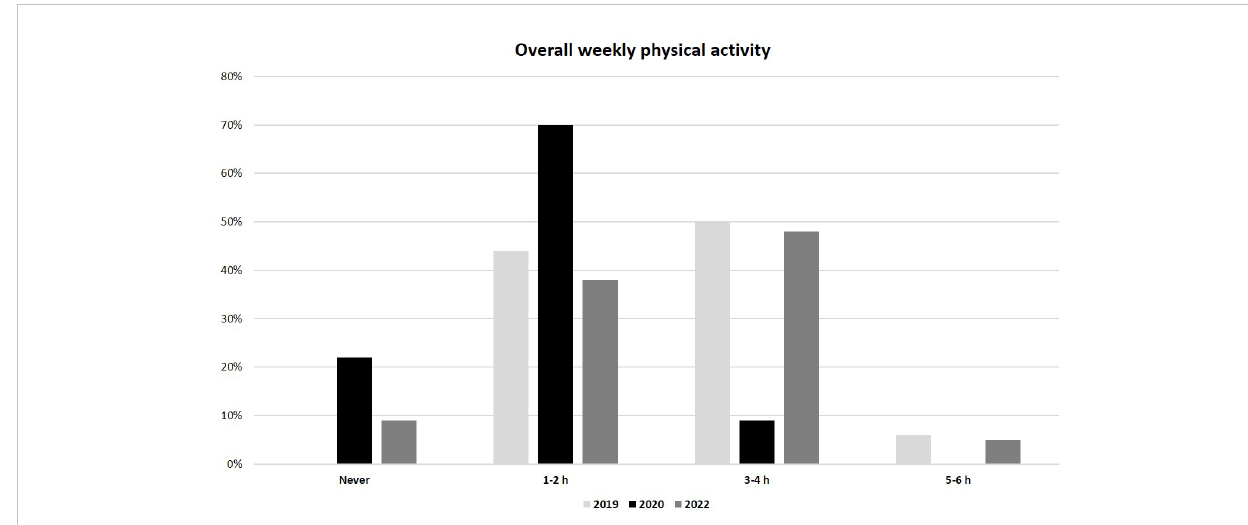
FIGURE 3 Overall weekly physical activity in 2019, 2020 and 2022 populations.